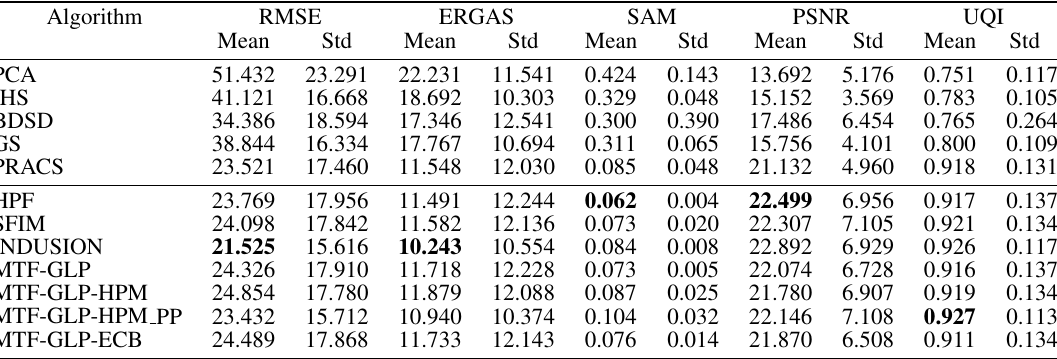
Table 2. Quality indices for the raw band grayscale Thermal Pansharpened images from the FLIR ADAS dataset for each